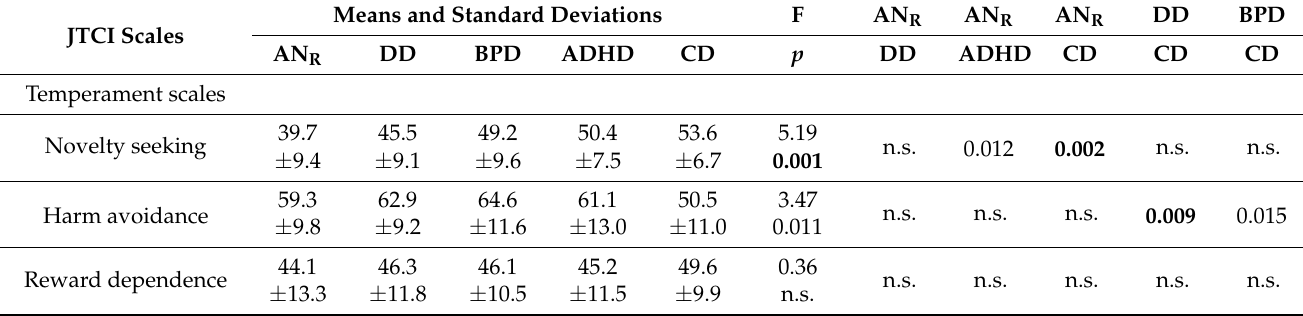
Table 3. Means and standard deviations of t-values of scales of Junior Temperament and Char- acter Inventory (JTCI) for mental-disorder groups. One-way analysis of variance (ANOVA) and Bonferroni post hoc tests analysis. Only samples with Bonferroni post hoc tests calculations that feature significant values are included ( α -level ≤ 0.01 (bold print), α -level ≤ 0.05 (light print)), n.s. = not